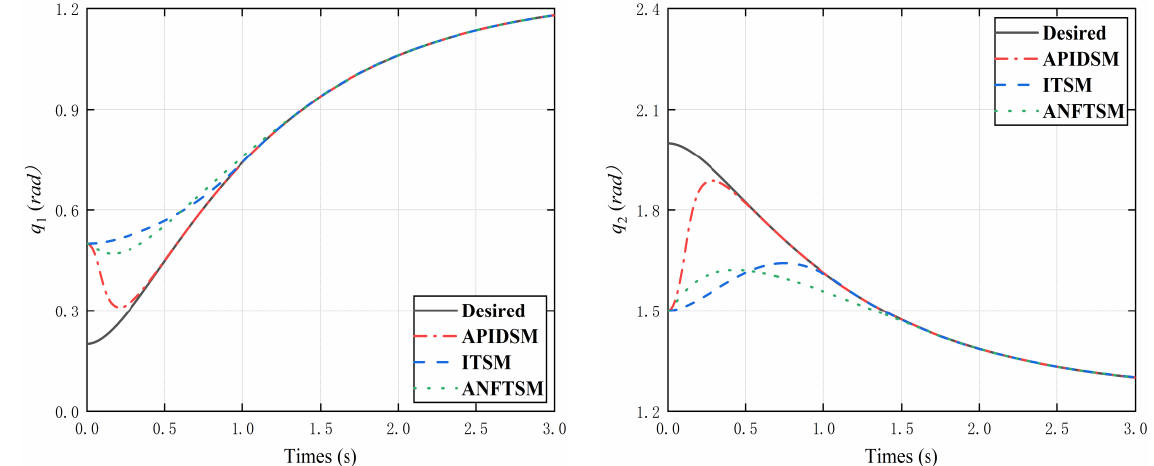
Figure 10. Comparison of position tracking results between controllers of Joint 1 and Joint 2.